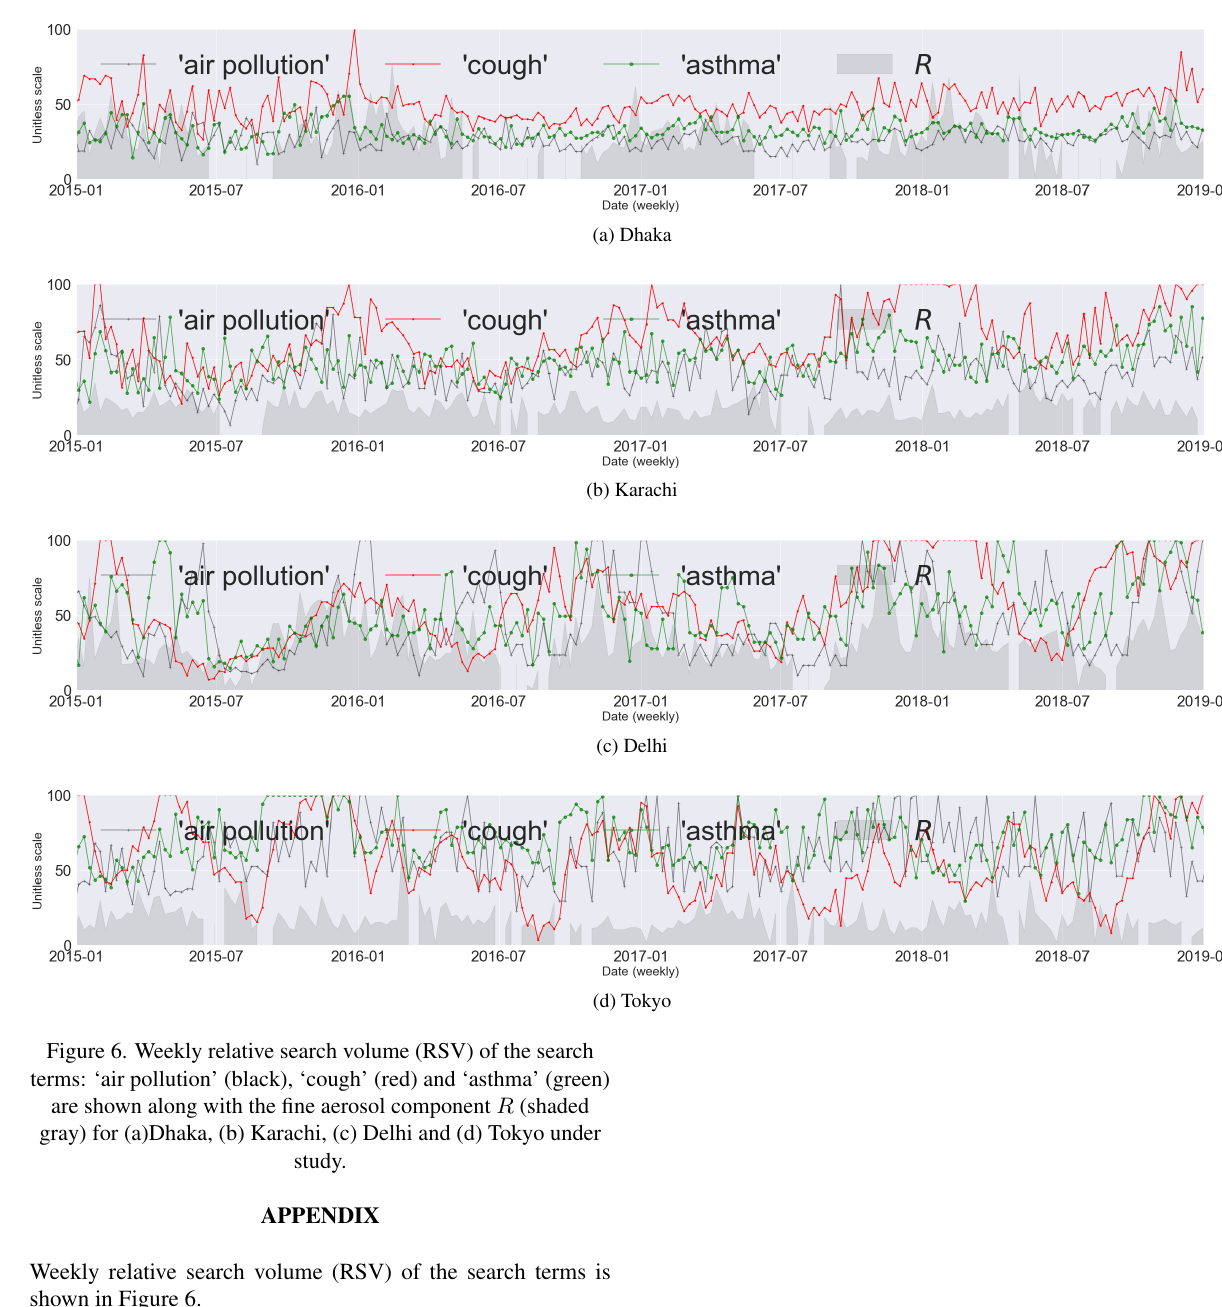
Weekly relative search volume (RSV) of the search terms is shown in Figure